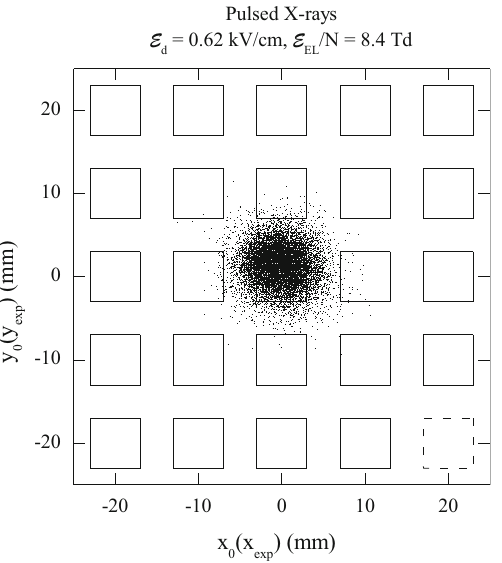
Fig. 19 Direct SiPM-matrix readout: 2D coordinate distribution of reconstructed events in x 0 ( x exp ) , y 0 ( y exp ) plane. The solid boxes are the active SiPMs and the dashed box is the inactive SiPM (the photo- electronnumberinwhichwasdeterminedastheaverageoftwoadjacent channels). The data were obtained at the maximum reduced EL field, of 8.4 Td, when the detector was irradiated by pulsed X-rays through a 2 mm